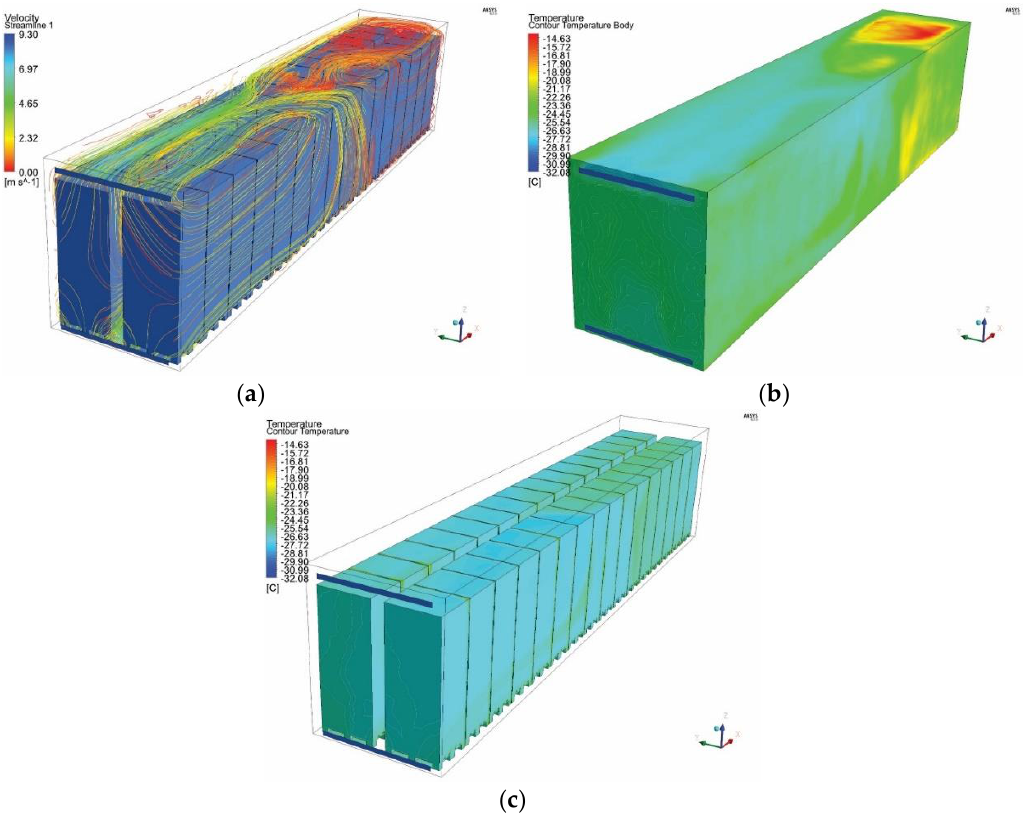
Figure 3. The stationary model of turbulent flow, method: Reynolds stress model (RSM) ( a ) streamline: velocity magnitude (m/s), ( b ) external temperature (°C) distribution, ( c ) internal temperature (°C) distribution.